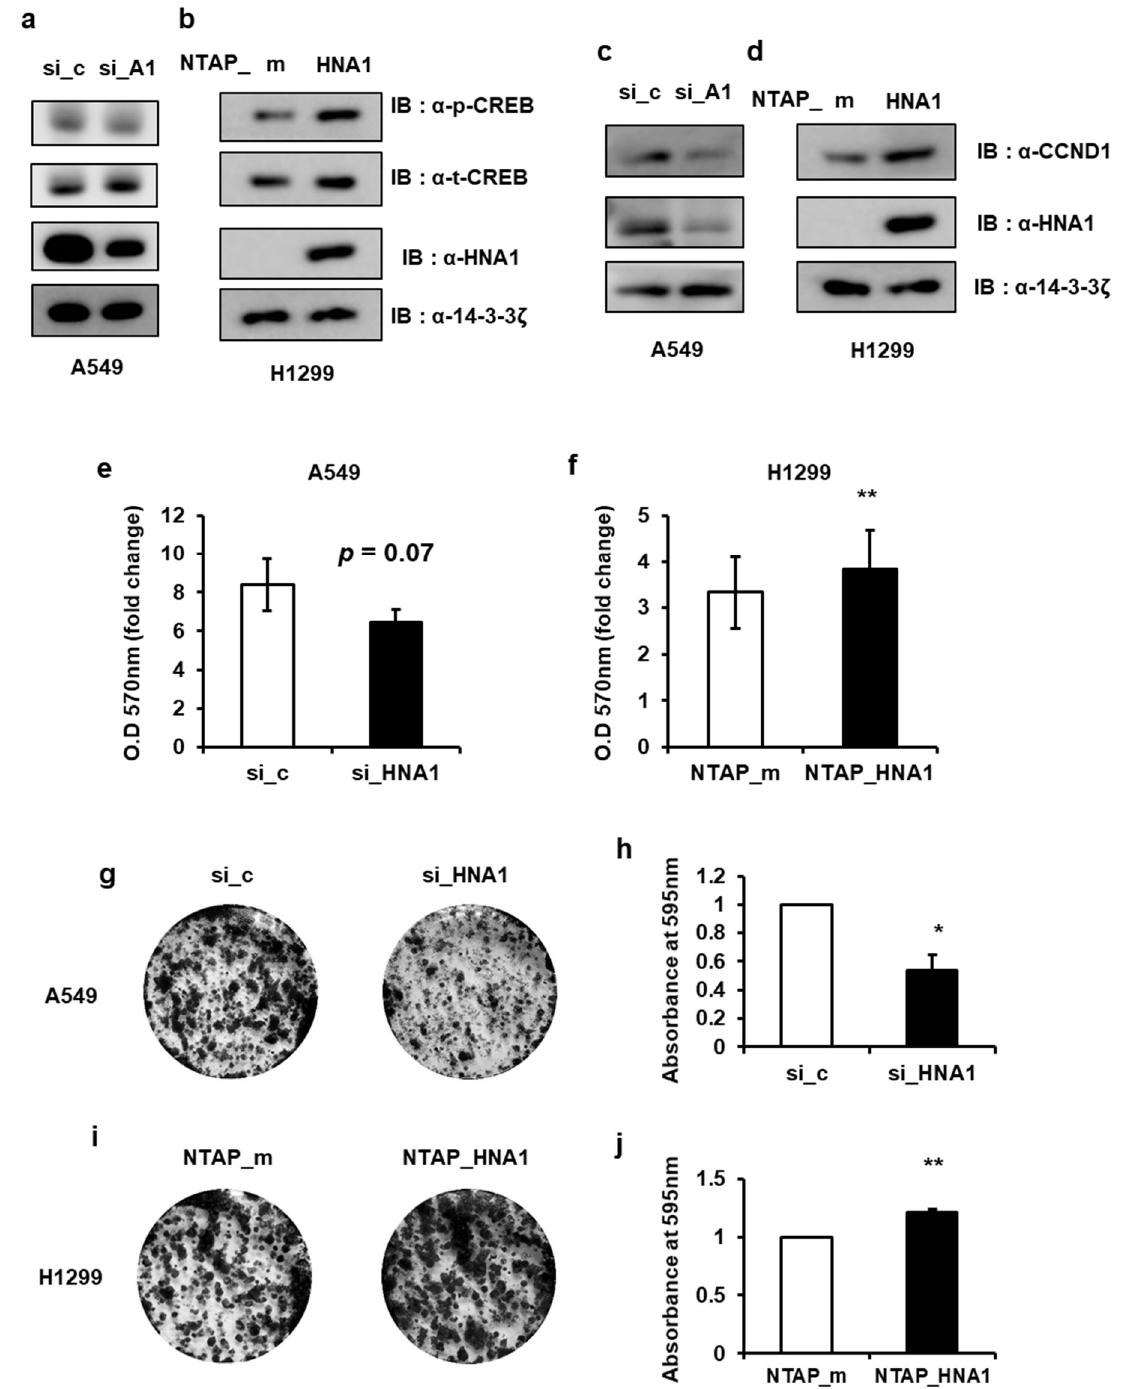
Figure 6. HNRNP A1 regulates lung cancer cell proliferation. ( a , c ) A549 cells were transfected with either si_con (si_c) or si_HNRNP A1 (si_HNA1). Cells were immunoblotted with the indicated antibodies. ( b , d ) Immunoblotting of cell lines stably expressing NTAP_HNRNP A1 (NTAP_HNA1) was performed. Western blot analysis was performed with the indicated antibodies. ( e , f ) Cell proliferation of cells after HNRNP A1 silencing or of NTAP_HNRNP A1 stably expressing cells were assessed with MTT assays for 5 days after seeding. Cell proliferation (%) were calculated relative to that of at the time of transfection, which was set to 100%. ( g – j ) Colony formation assays were performed. Cells were grown for 10 days and were stained with crystal violet (left). Colonies were quantified by measuring the absorbance of extracted crystal violet at 595 nm (right) (* p < 0.05, ** p < 0.01).